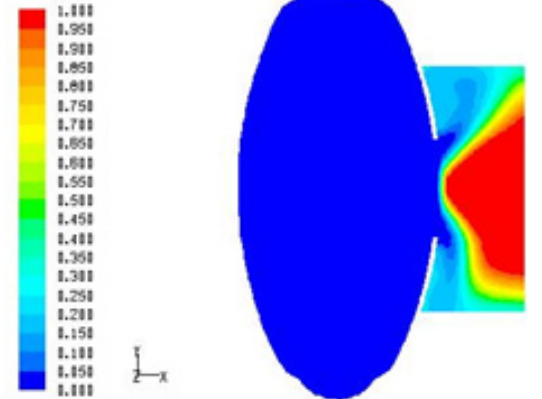
Fig. 3-8. Continuation of the previous for the max. defined water level (pressure). The higher part of the sprayed flow hits the inner walls of the flange and is rotating there.